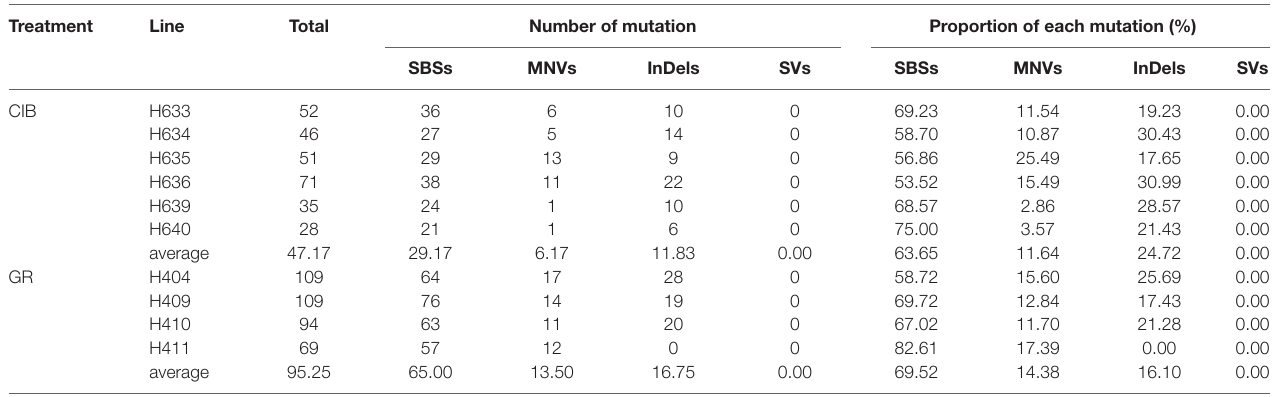
TaBLe 2 | Summary of mutation information of individual lines. Treatment Line